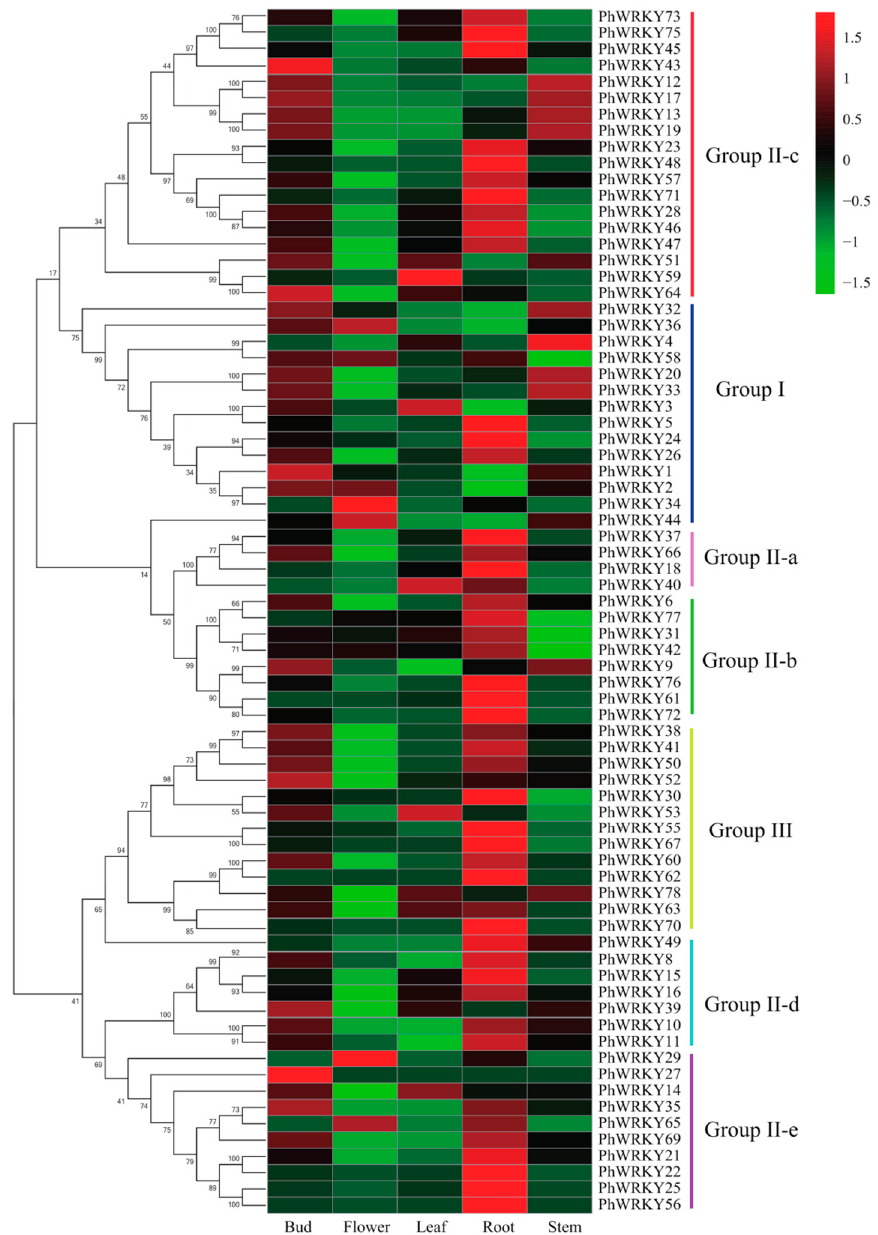
Figure 4. Expression analysis of PhWRKY genes in five tissues of Petunia .